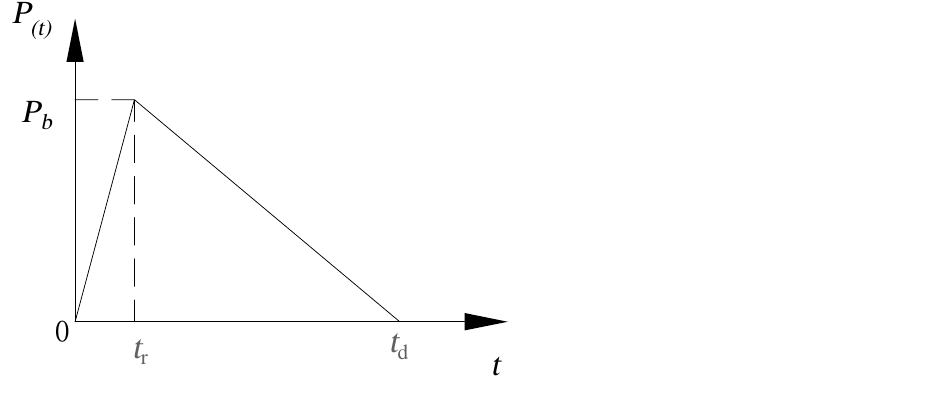
Figure 2. Triangular blasting load